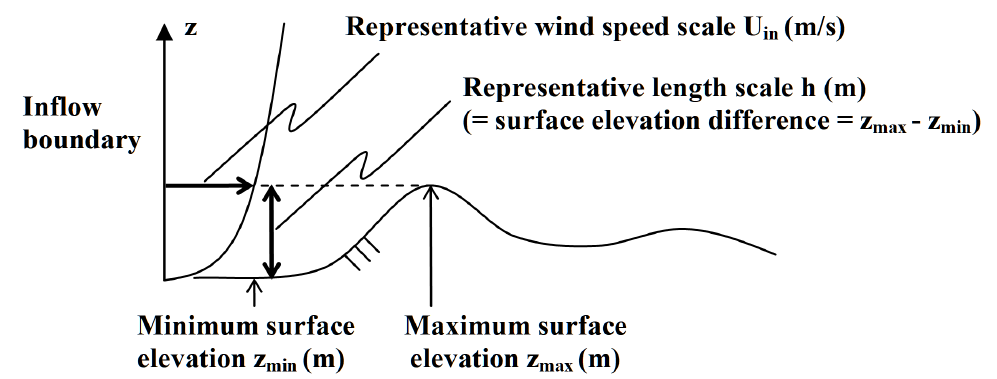
Figure 23. Representative scales used in the present study.